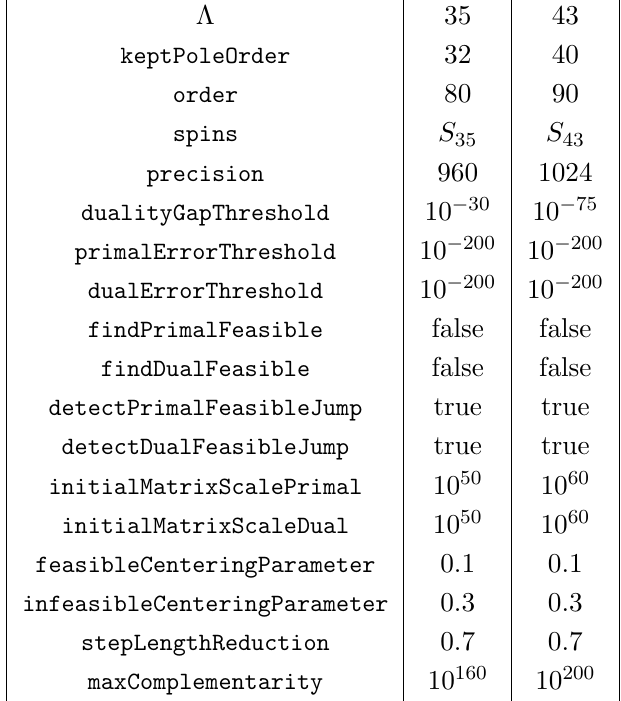
Table 5 . Parameters for the computations in section 4.2. The sets S 35 ; 43 are de(cid:12)ned in (B.1).